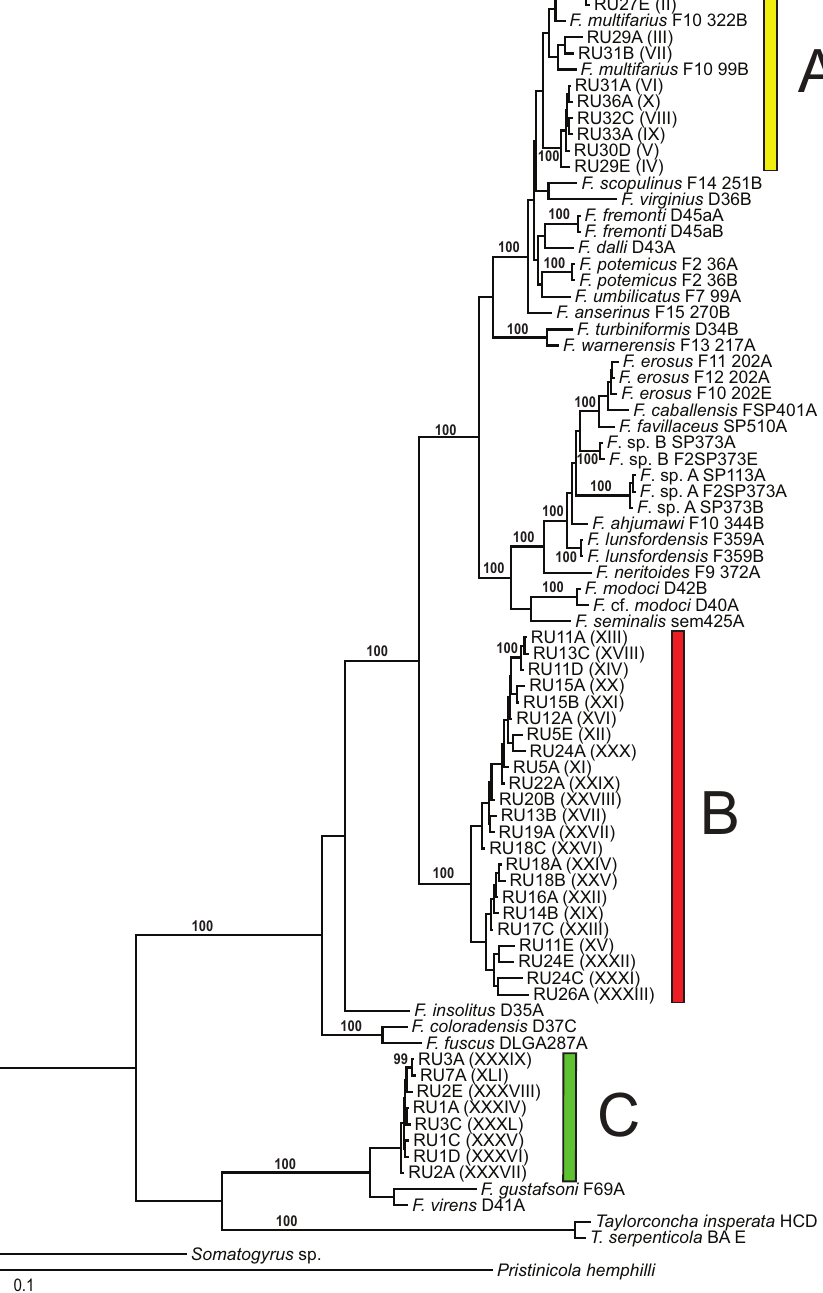
Figure 1. Bayesian tree based on the COI dataset. The three clades ( A–C ) containing Rogue-Umpqua hap- lotypes are color coded as in Figure 2. Posterior probabilities for nodes are shown when >95%. Specimen codes are from Suppl. material 1; Rogue-Umpqua haplotype codes (in parentheses) are from Suppl. material